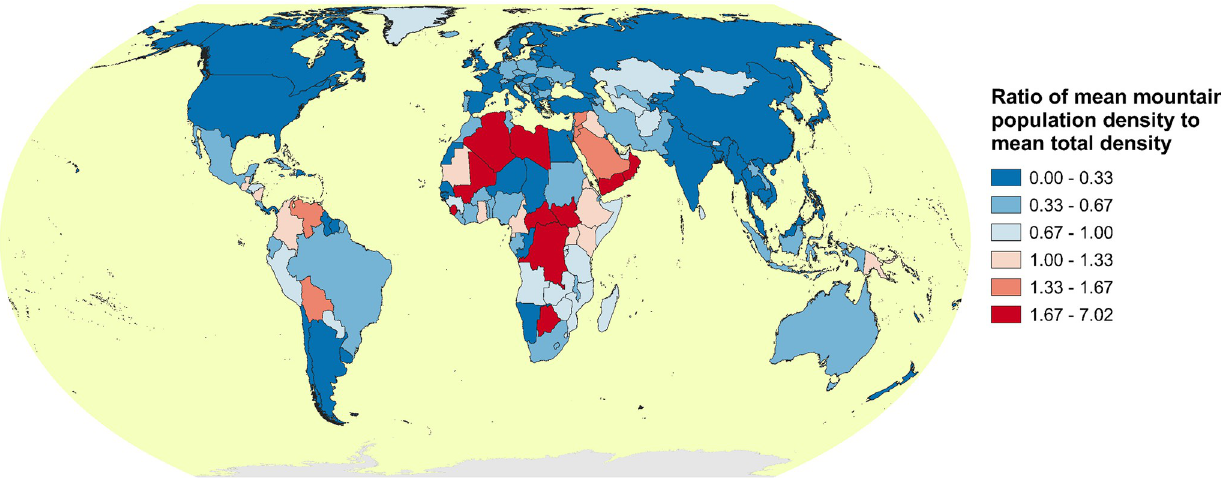
Fig 5. Ratio of 2020 mean mountain-only population density to mean total population density by IPBES areas according to the K2 delineation and WorldPop population. The 0.145 value corresponds to all “Small Island” regions globally.